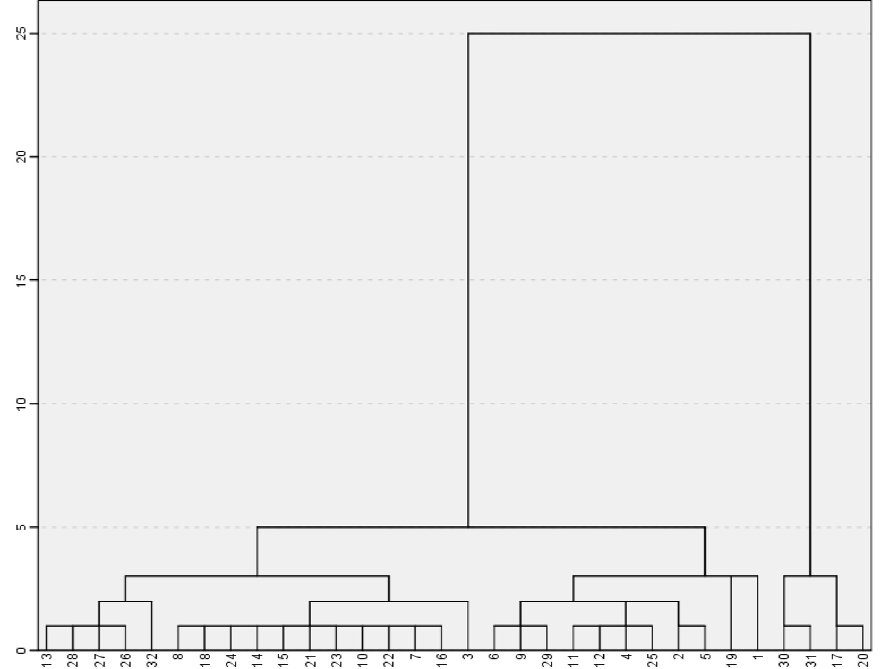
Figure 3. The Q-mode hierarchical clustering analysis of the investigated 32 sediment samples.